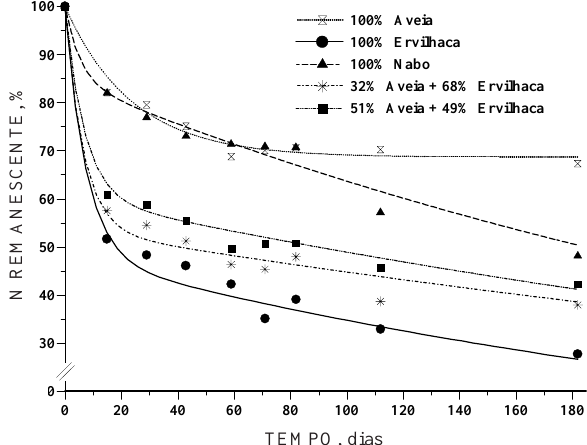
TEMPO, dias Figura 3. Nitrogênio remanescente dos resíduos culturais de plantas de cobertura solteiras e consorciadas, em avaliações realizadas até 182 dias após a distribuição das bolsas de decomposição na superfície do solo.